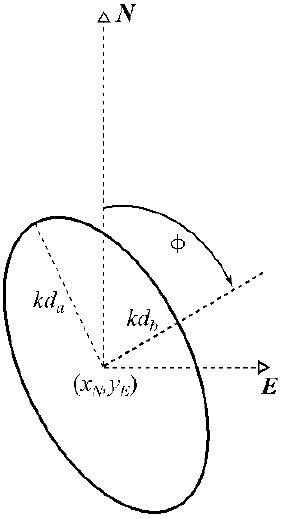
Figure 4. Elliptical representation of an SBAS based protection area.